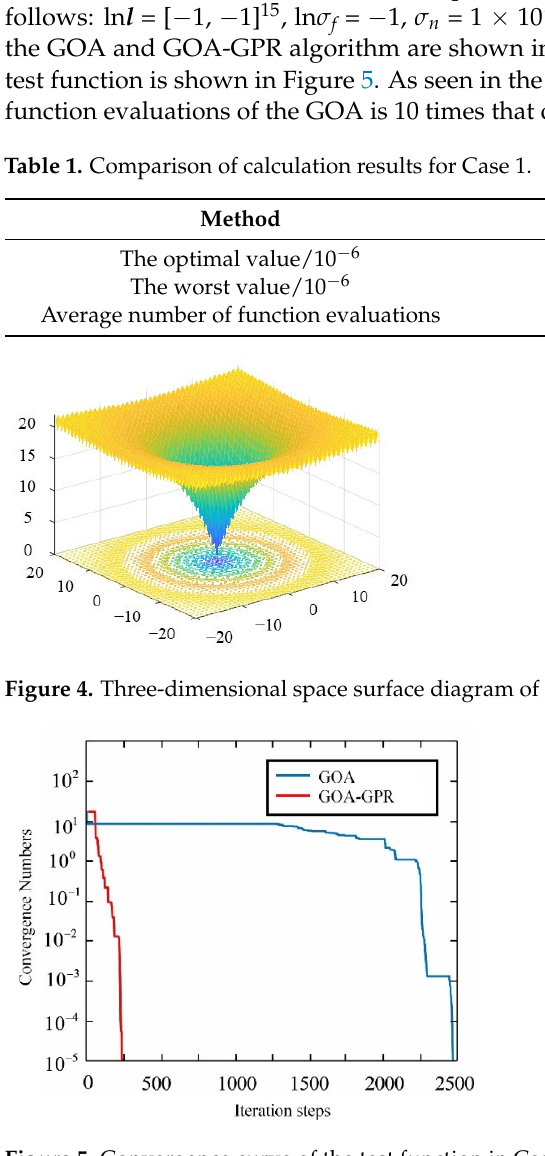
Figure 5. Convergence curve of the test function in Case 1.